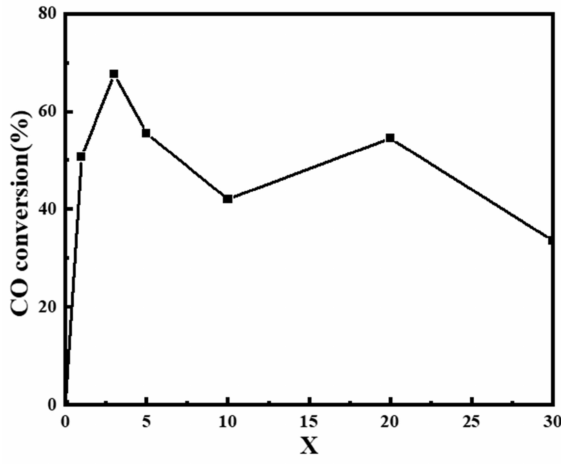
Figure 10. CO conversion and conversion of x CuO/ α -MnO 2 -200-DP ( x = 0, 1, 3, 5, 10, 20, 30) catalysts with different CuO loading at 60 ◦ C.